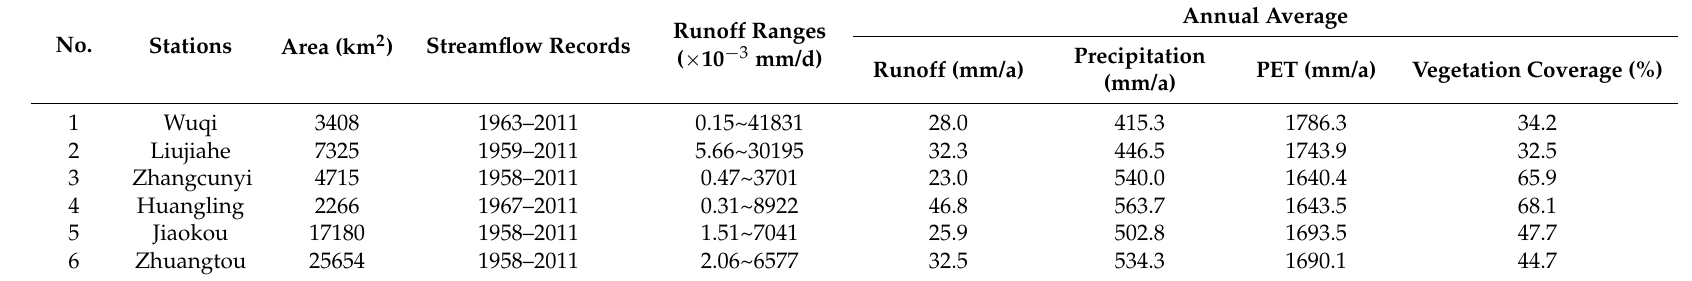
Table 2. Characteristics and streamflow records for all